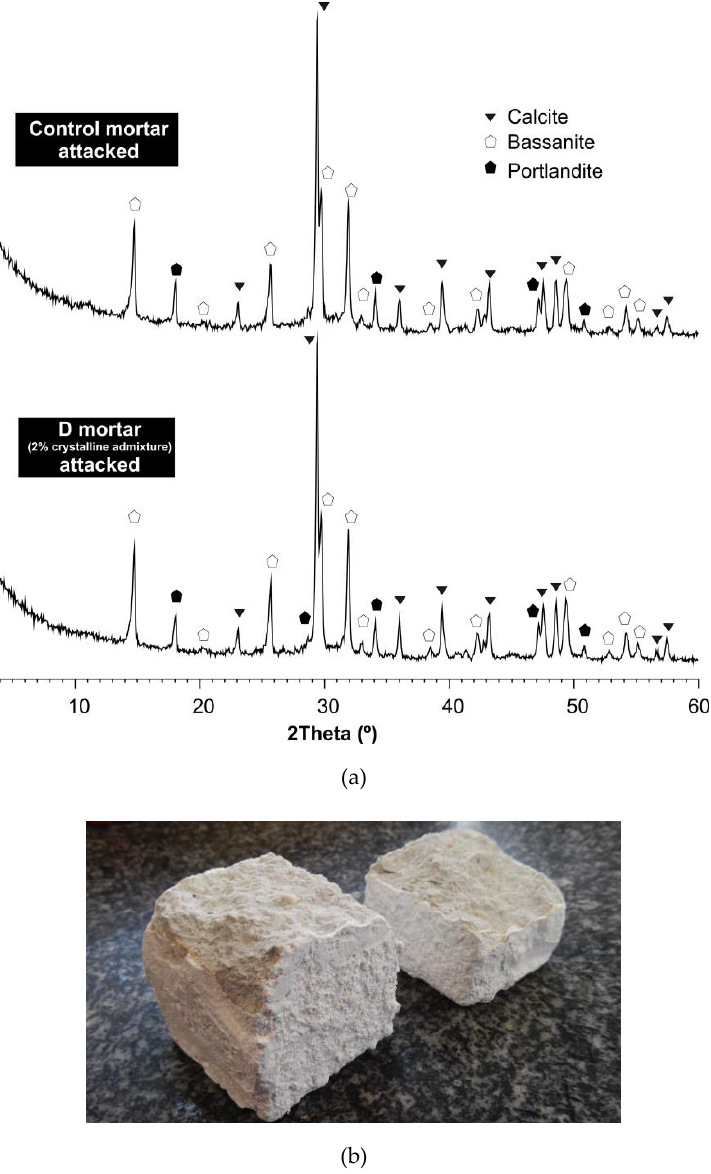
Figure 5. ( a ) X-ray diffraction spectra of control mortar and D mortar (with crystalline admixture) after 90 days of sulphuric acid attack; ( b ) Specimens exposed to the acid attack after compressive strength testing at t 118(90) , where the massive formation of gypsum in the surface of the specimen can be seen.